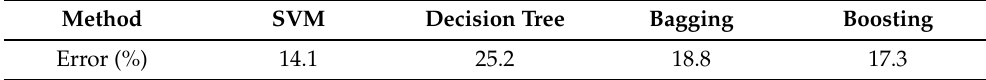
Table 1. Error rate of the classifier via the direct supervised learning